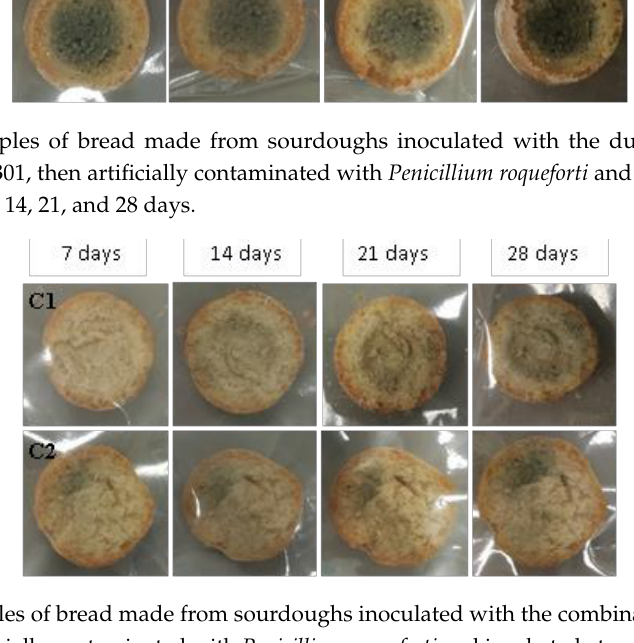
Figure 17. Examples of bread made from sourdoughs inoculated with the combination of isolates C1 and C2, then artificially contaminated with Penicillium roqueforti and incubated at room temperature for 7, 14, 21, and 28 days.